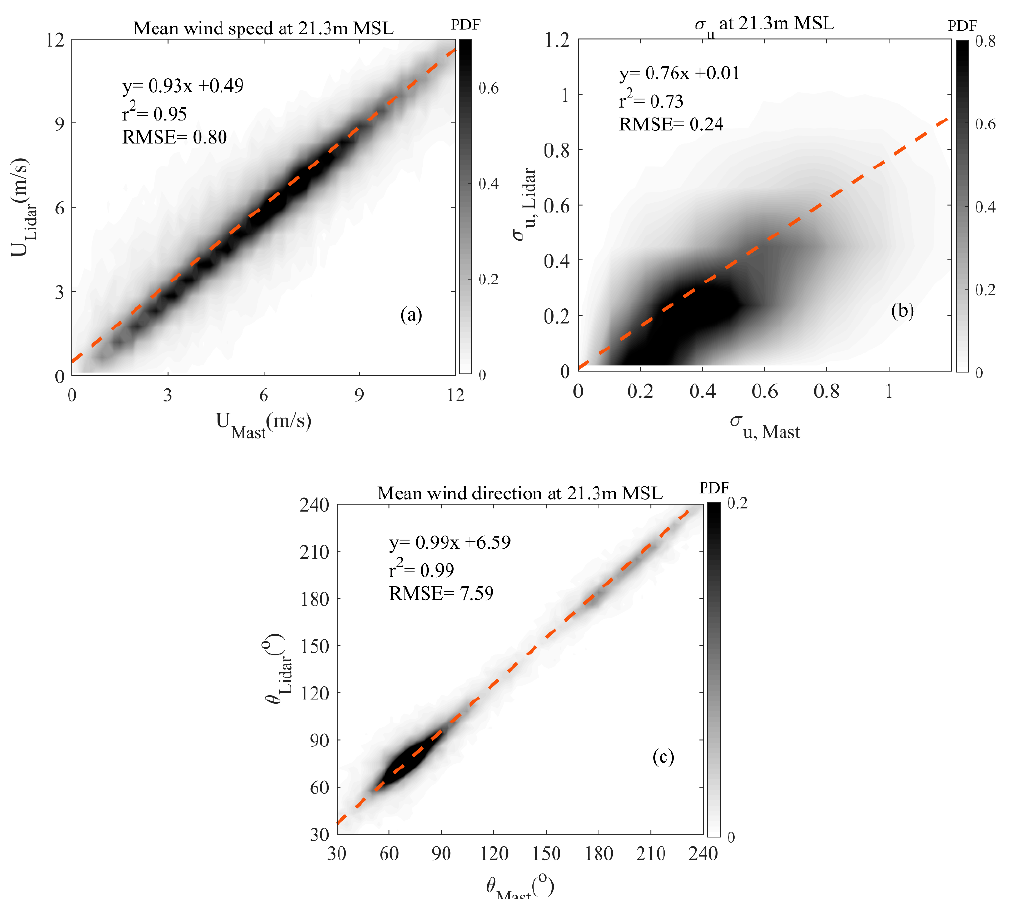
Figure 3. Comparison of mast and wind Lidar measurements at 21.3 m above mean sea level (MSL) (each pixel represents the probability density function (PDF) normalized by the maximum PDF value; red dotted line represents the best linear fit). ( a ) mean wind speed ( b ) standard deviation of wind speed ( c ) mean wind direction.